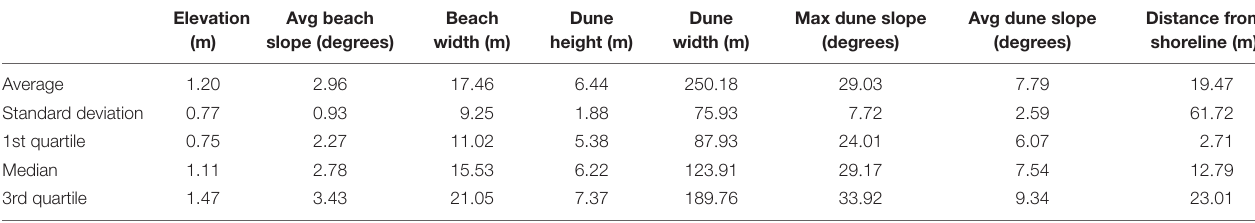
Avg dune slope (degrees)